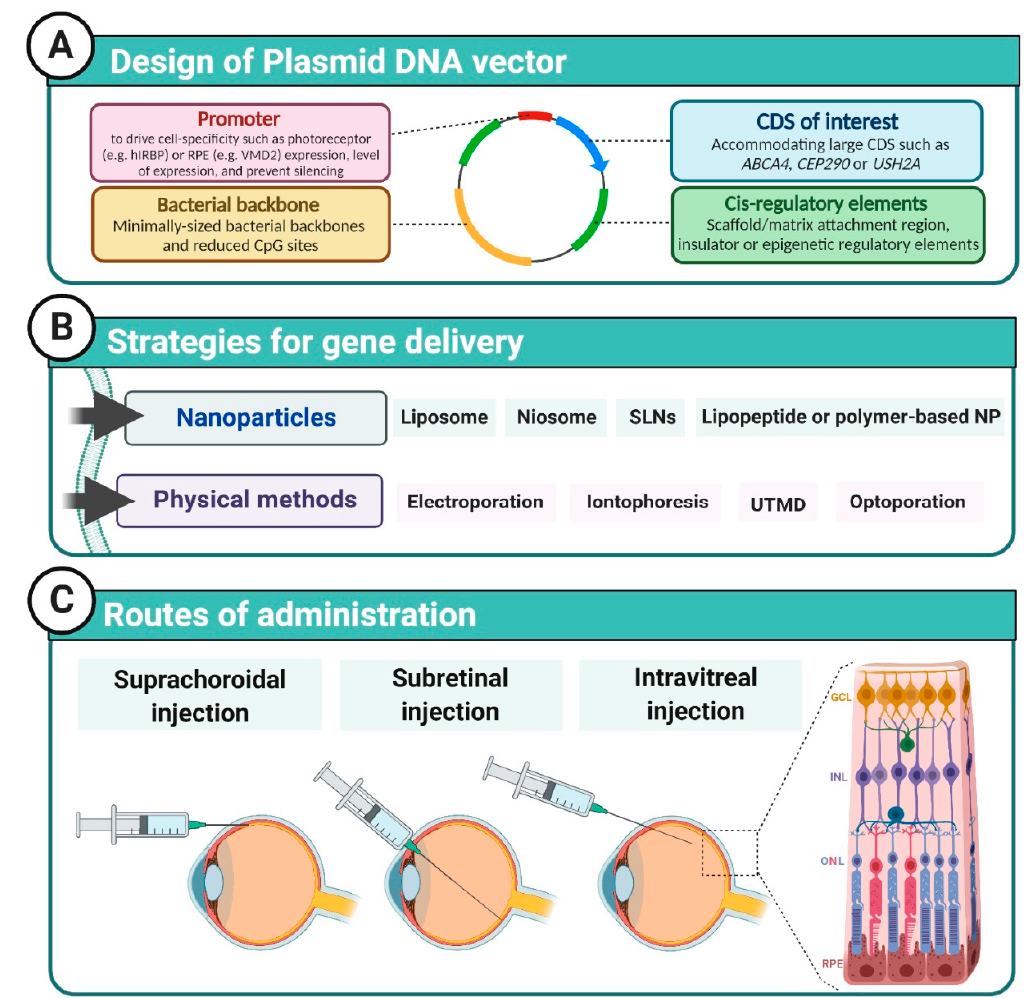
Figure 1. Retinal non-viral gene therapy. ( A ) Plasmid DNA vectors are designed to ensure cell-specific, long-lasting, and safe expression of the transgene of interest. ( B ) Different physical or chemical strategies can be applied to aid DNA transfection in the necessary cells ( C ) Different routes of administration can be used depending on the gene delivery strategy and the targeted cells. CDS: coding sequence; GCL: ganglion cell layer; INL: inner nuclear layer; ONL: outer nuclear layer; SLNs: solid-lipid nanoparticles; UTMD: ultrasound-targeted microbubble destruction (Created with BioRender.com (accessed on 1 February